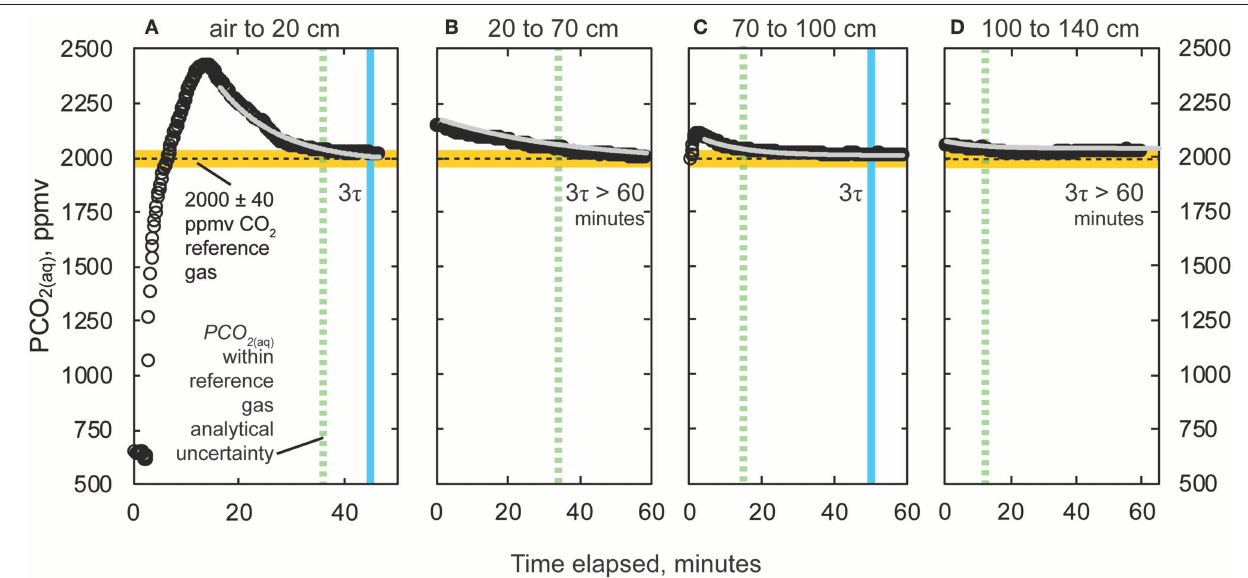
FIGURE 8 | Change in PCO 2(aq) and time elapsed lowering from (A) air to 20cm, (B) 20 to 70cm, (C) 70 to 100cm, and (D) 100 to 140cm depth intervals. Recorded values missed initial peaks when submerged for (B) (20 to 70cm) and (D) (100 to 140cm) due to lagged start time on data logger. Modeled equilibration and three e-folding times are shown for (A) (20cm) and (C) (100cm). Estimated three e-folding times were > 60min on (B) (70cm) and (D) (140cm). However, the time is denoted in all panels when values are within analytical uncertainty of the reference gas mixture (hatched green line). Measurements made using the K30 10% gas